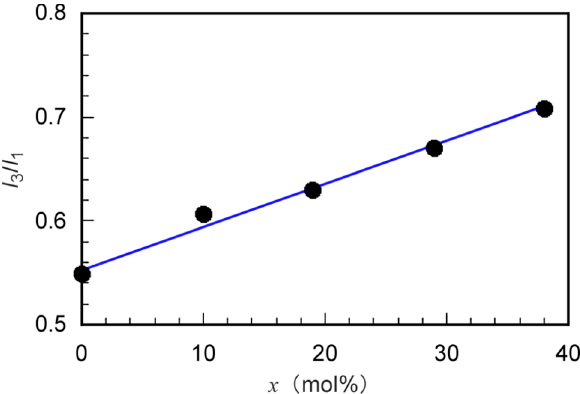
Figure 8. Pyrene fluorescence vibrionic peak intensity ratio ( I 3 / I 1 ) in the presence of P(MPC/DMA x ) as a function of DMA content ( x ): I 3 and I 1 are the intensities of third and first vibrionic peaks in pyrene fluorescence, respectively.